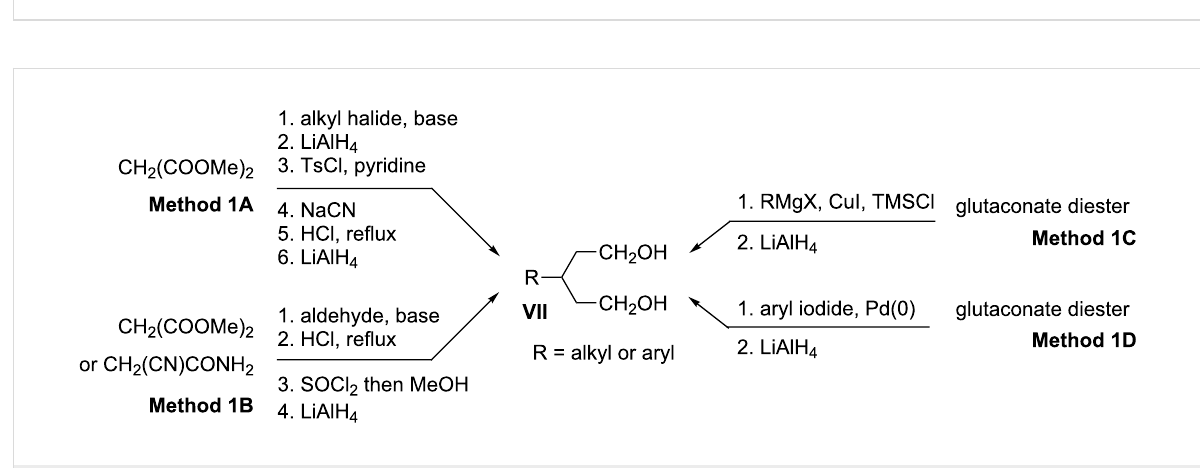
Scheme 1: General methods for preparation of diols VII